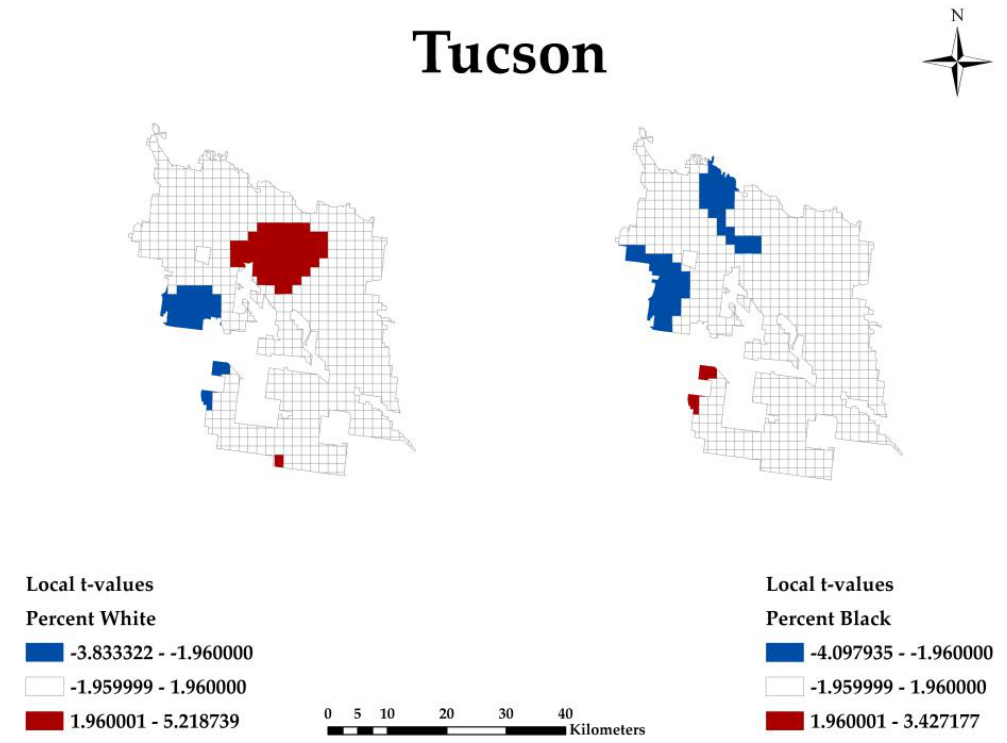
Figure 16. Tucson growing city Percent White and Percent Black: 95% two-tailed test (−1.96:1.96).